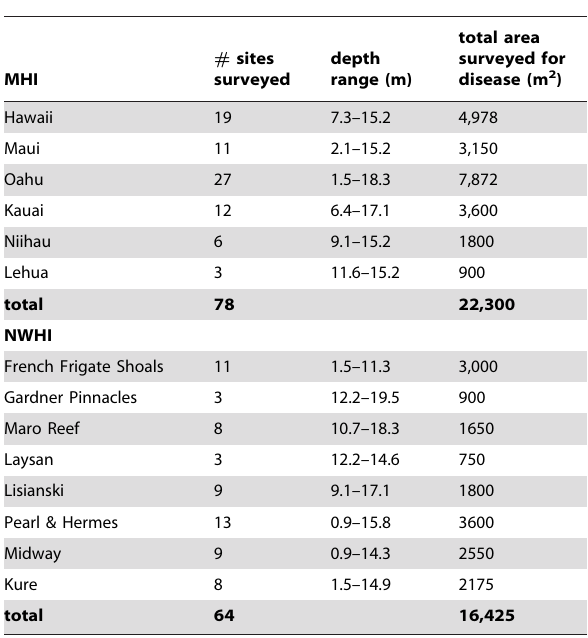
Table 1. Disease surveys conducted in the main and northwestern Hawaiian Islands in 2004 and